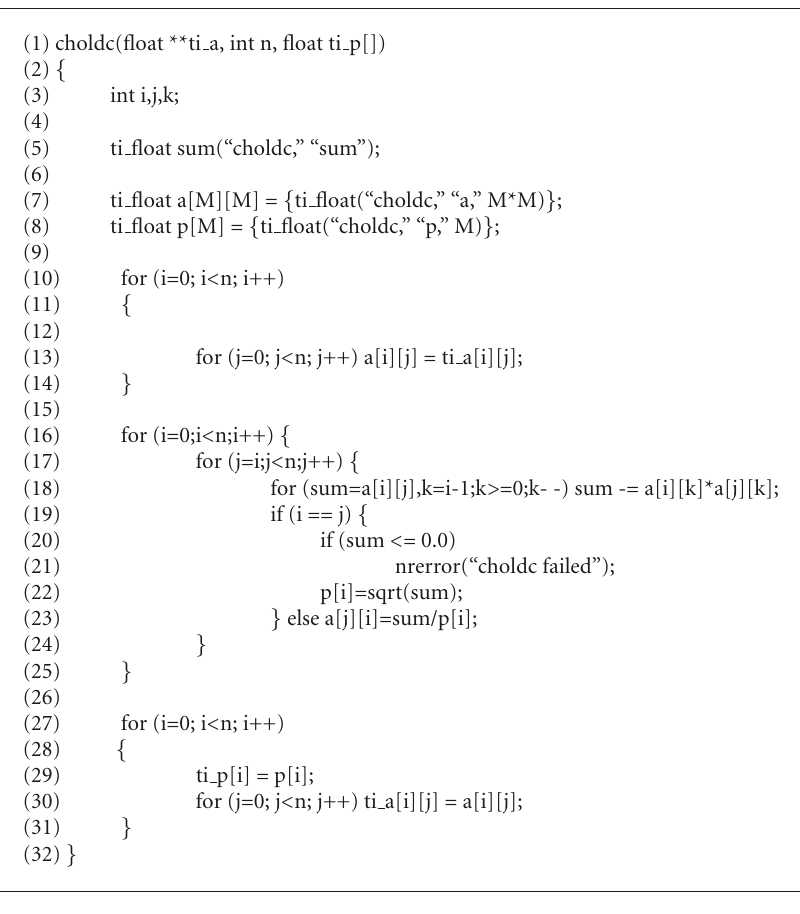
Figure 7: Floating point code for Cholesky decomposition prepared for range estimation.